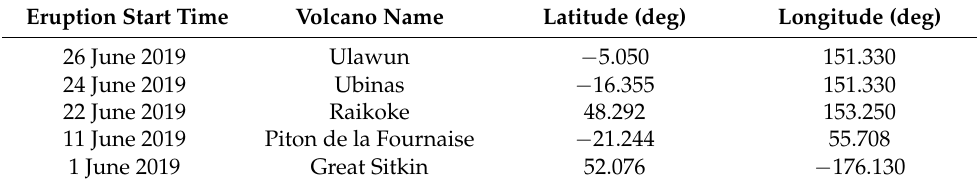
Table 1. Sample from the volcanoes of the world (VOTW) [27].